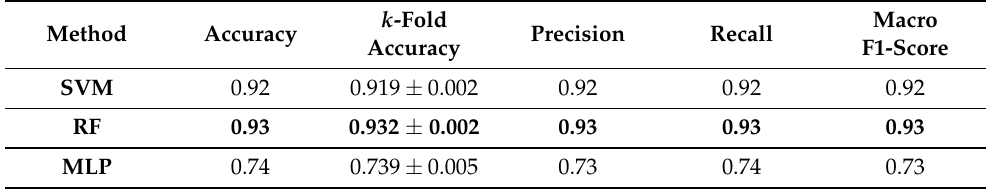
Table 4. Performance metrics for the SVM, RF and MLP models.